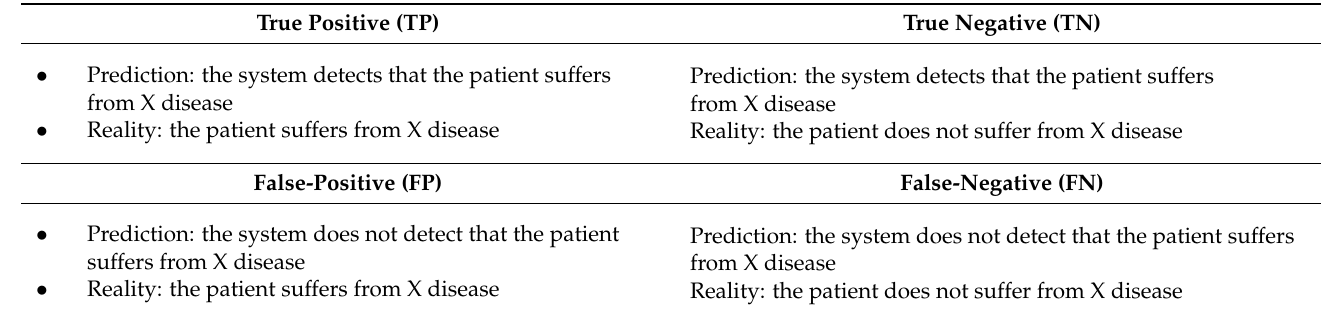
Table 4. Confusion matrix 2 × 2.